Question: Write a single sentence explaining what this figure depicts.
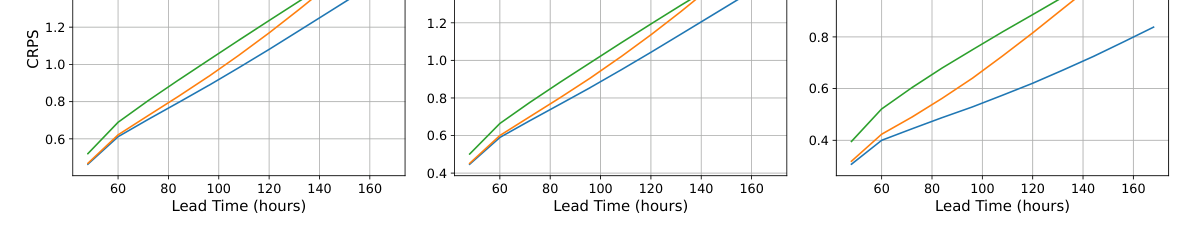
Answer: Lagged ensemble forecast performance for v10, u10, and t2m across three model configurations: the baseline model using channel- weighting, and two fine-tuned versions of that model using 4-step and 8-step fine-tuning. The first row is ensemble mean RMSE calculated over the 9 member ensemble, the second row is the spread skill calculated by dividing the standard deviations of predictions across the ensemble by the ensemble RMSE, and the third row is continuous ranked probability score calculated across the ensemble.